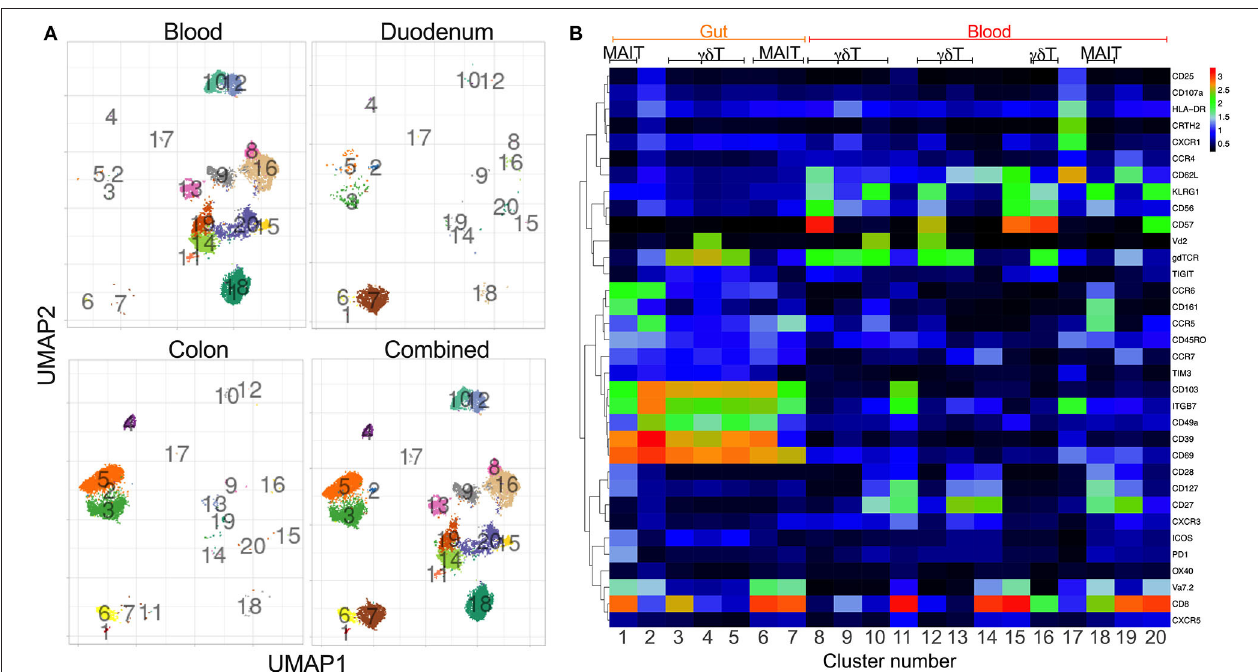
FIGURE 1 | Distinct phenotype clustering supports tissue-specific compartmentalization of unconventional T-cell subsets. Mass cytometry was performed on three colon (022-09-1140, 022-09-1182, 022-09-1183) and four duodenum samples (022-09-3120, 022-09-3121, 022-09-2187, 022-09-2188) with matched blood (see Supplementary Table 1 for individual participants’ characteristics). All participants were HIV negative. (A) Uniform manifold approximation and projection (UMAP) of blood, colon and duodenum of unconventional T-cell subsets (CD3 + V α 7-2 + γδ TCR + ; gating strategy Supplementary Figure 1A ). Events are color-coded according to cell marker clusters. (B) Heatmap shows the frequency of surface marker expression within the manually gated clusters from (A) . Scale bar indicates Log 2 of positive expression from low (black) to high (red) of the indicated